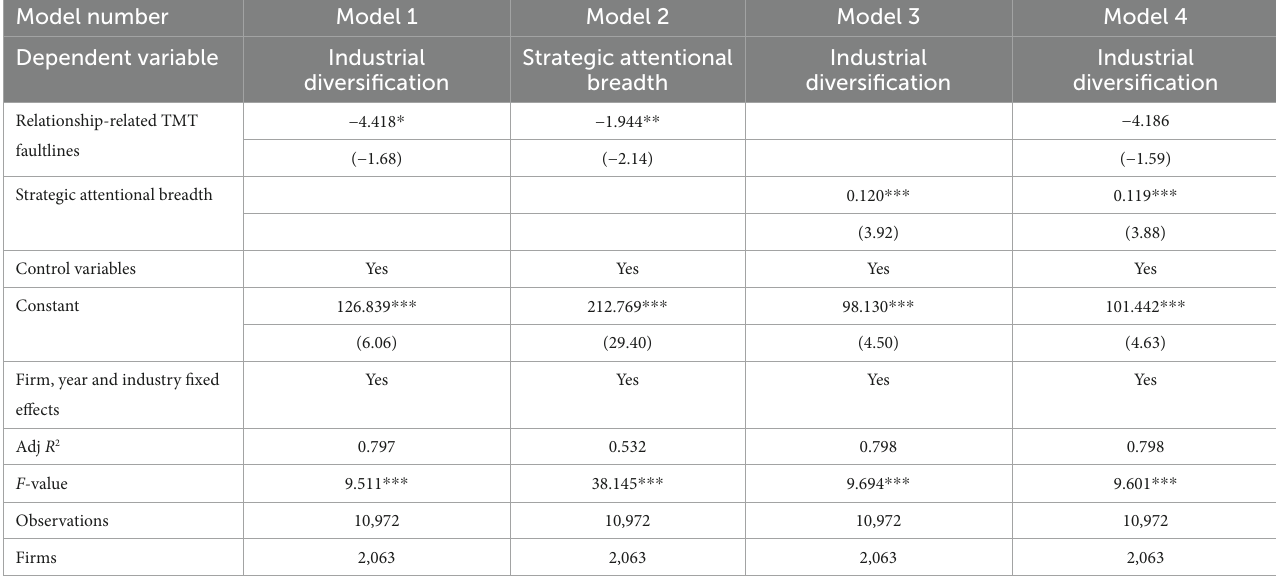
TABLE 5 Panel fixed-effects regression of the relationship between relationship-related TMT faultlines and corporate industrial diversification (measuring industrial diversification and strategic attentional breadth using the Entropy Measure). Model number